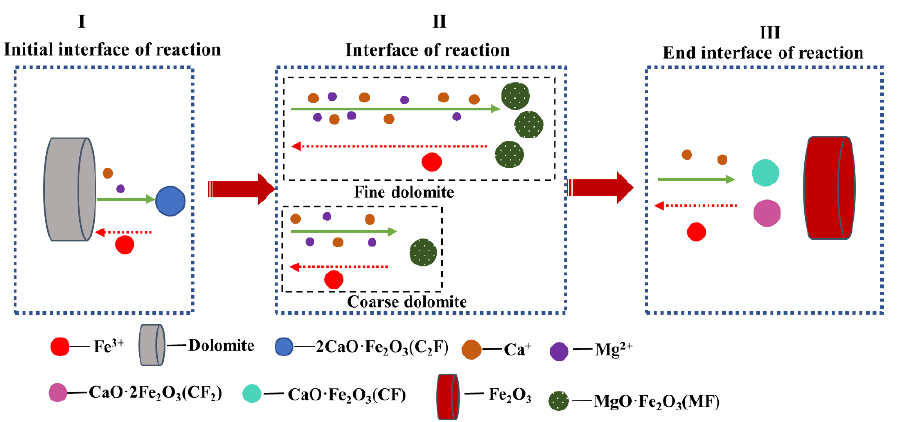
Figure 19. The mechanism diagram of mineralization reaction with different particle sizes of dolo- mite.